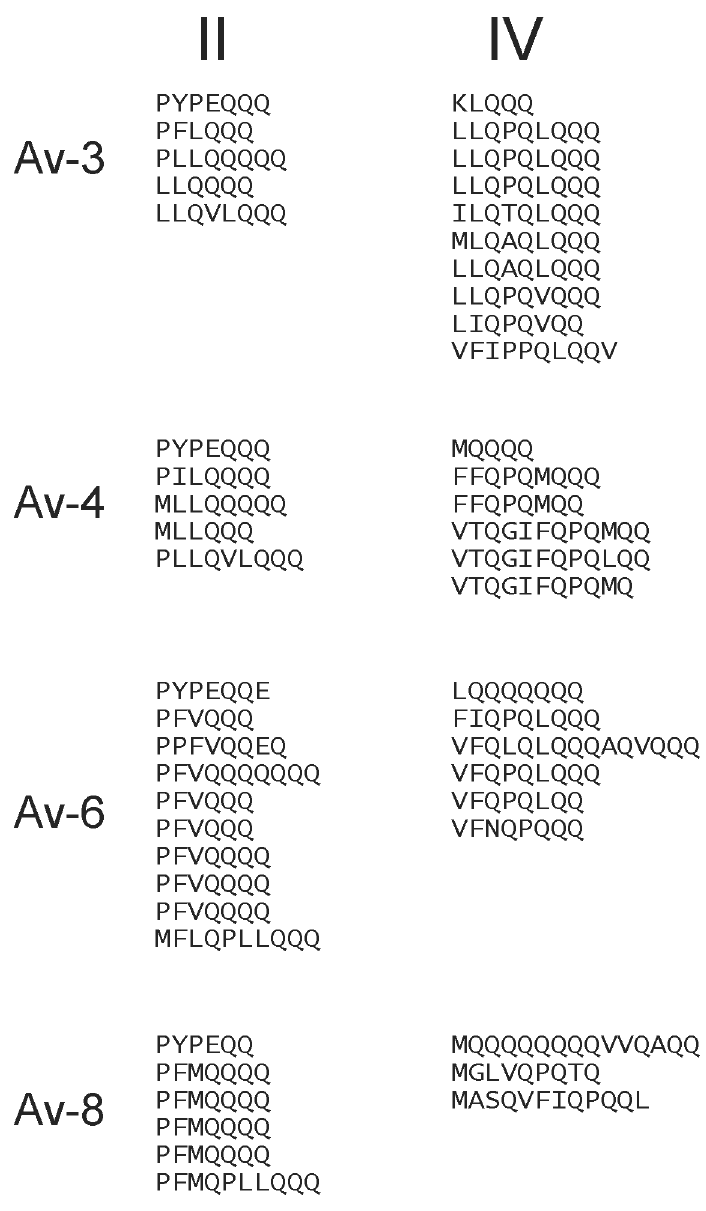
Figure 4. Avenin repetitive units. The repetitive units for domains II and IV are arrayed vertically for four of the CDC Dancer avenins.